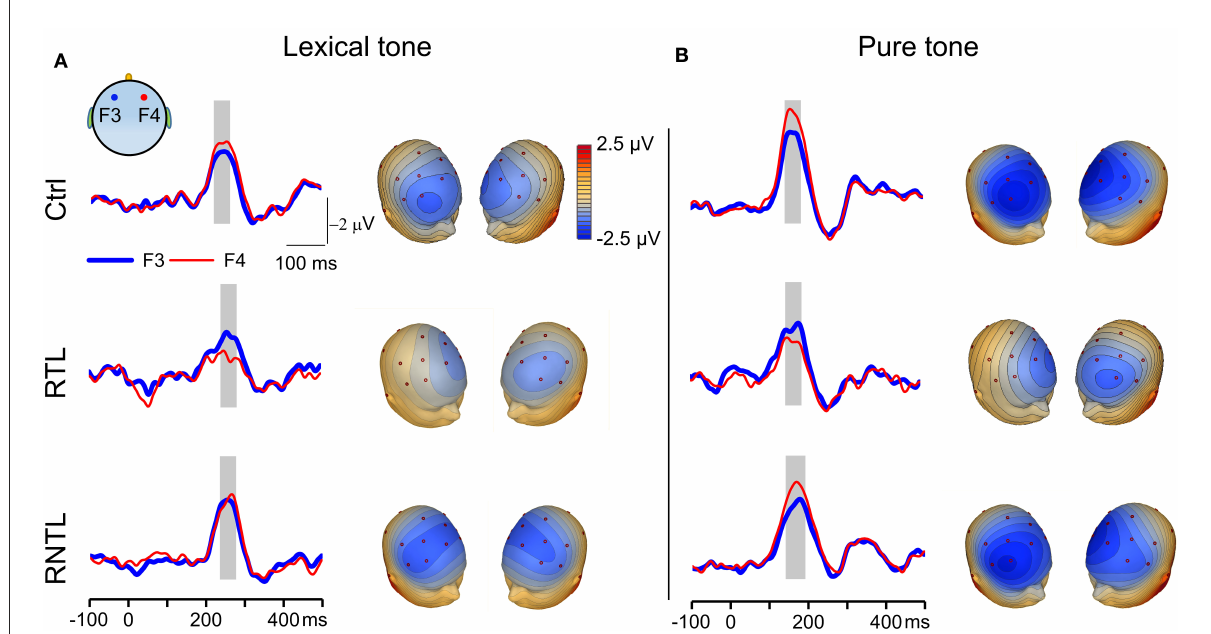
FIGURE2 MMN responses recorded on the left and right sides of the scalp. (A) Grand average traces of MMN evoked by the lexical-tone contrast were recorded from one pair of electrodes on the left (F3, thick blue lines) and right (F4, thin red lines) sides in the control (Upper, n = 14), RTL (Central, n = 11), and RNTL (Lower, n = 13) groups (Left). Gray bars indicate the time window in which MMN amplitude was calculated. Scalp topographic maps constructed from grand average MMN evoked by the lexical-tone contrast are shown at the time point of MMN peak amplitude on electrode Fz (Right). (B) Grand average traces recorded from one pair of electrodes on the left and right sides (Left) and grand average scalp topographic maps (Right) of MMN evoked by the pure-tone contrast in the control (Upper, n = 14), RTL (Central, n = 11), and RNTL (Lower, n = 13) groups. Gray bars indicate the time window in which MMN amplitude was